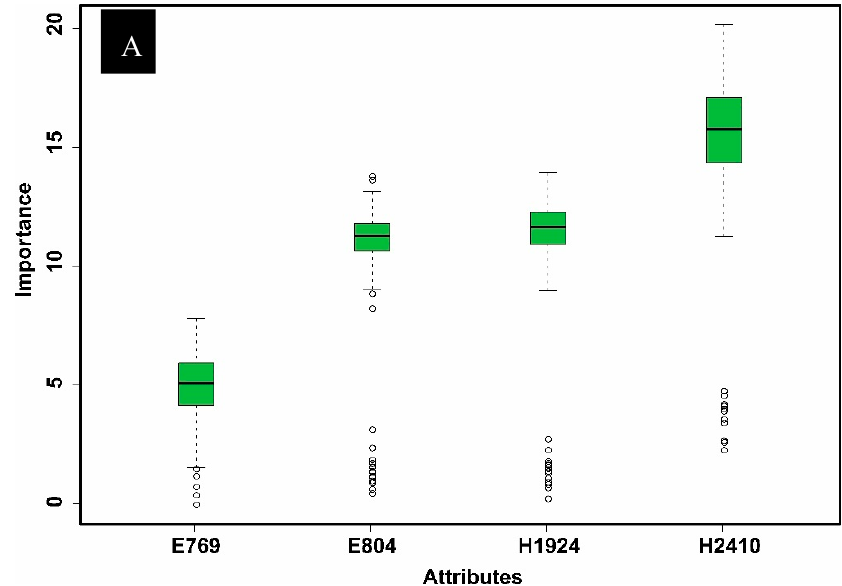
Table 4. Number of significant variables identified from the feature selection analysis.